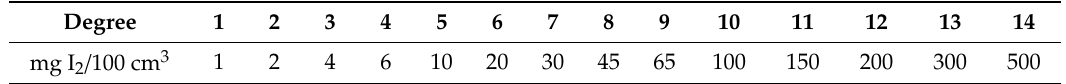
Table 3. Gardner’s iodometric